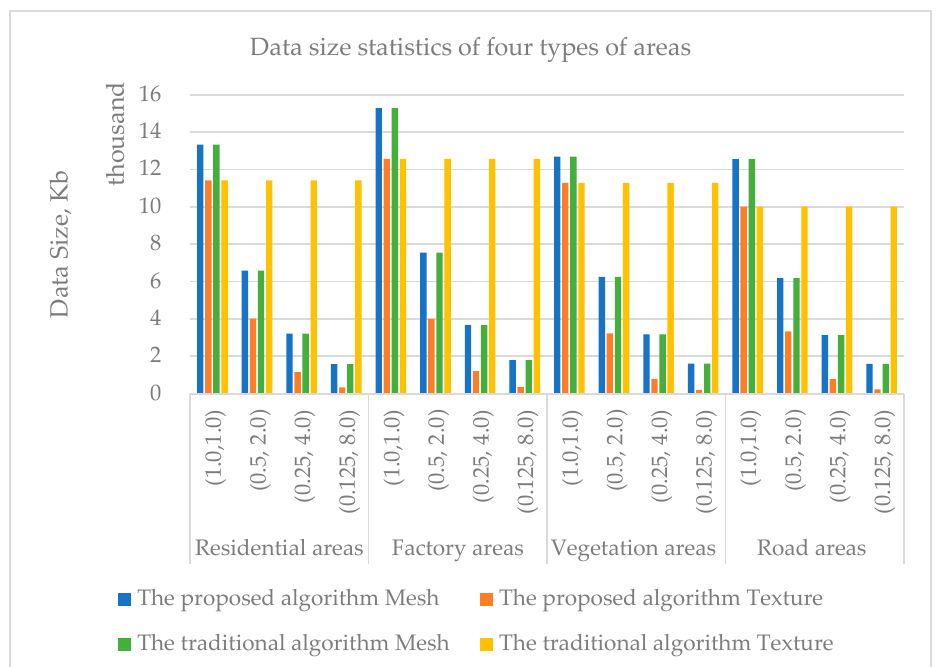
Figure 15. Histogram of data size statistics.